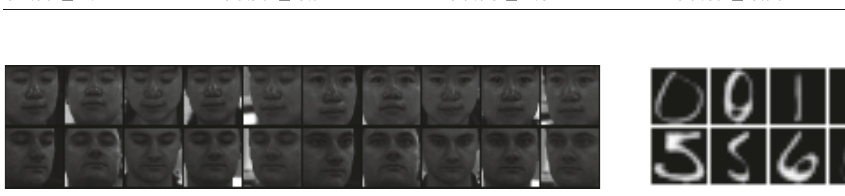
Figure 5: Example face images of two subjects from the PIE data set. Figure 6: Example digit images from the USPS data set.